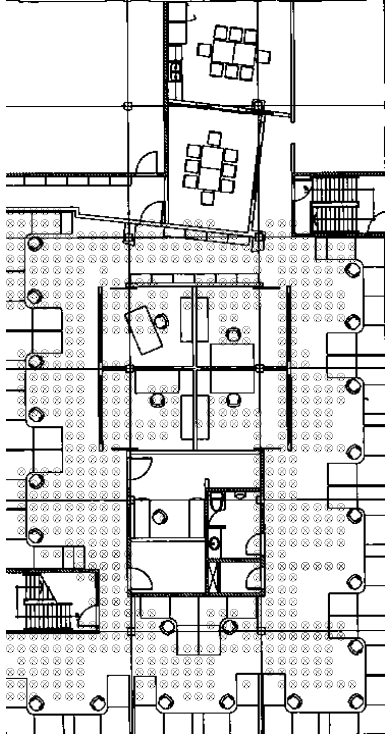
Figure 9. Office area with RSS sample points indicated by the markers.